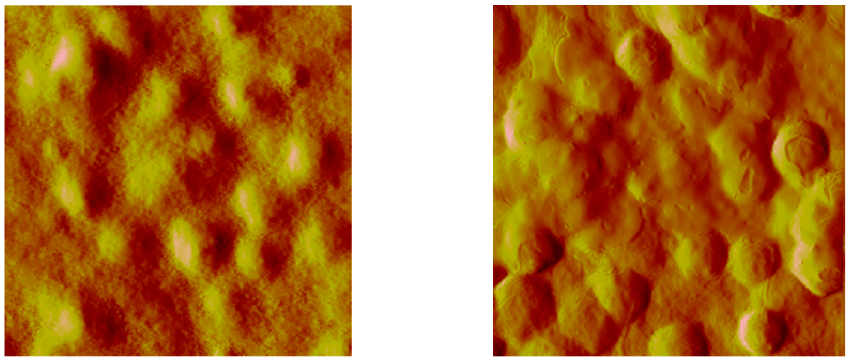
Figure 12. AFM images for M2 membrane (1 µ m). Left : new membrane. Right : membrane after chemical cleaning.